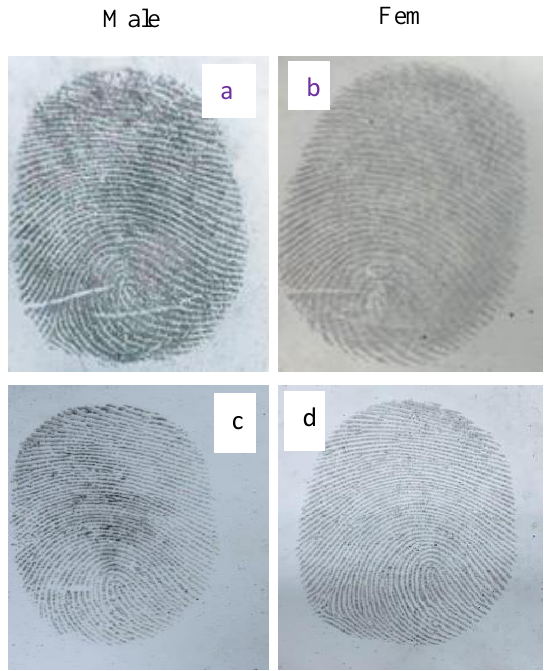
Fig. 9. Comparative visualization of latent fingerprints between commercial charcoal and AAC powders- (a) prepared powder (AAC) for males. (b) prepared powder (AAC) for females. (c) commercial charcoal for males. (d) commercial charcoal for females.